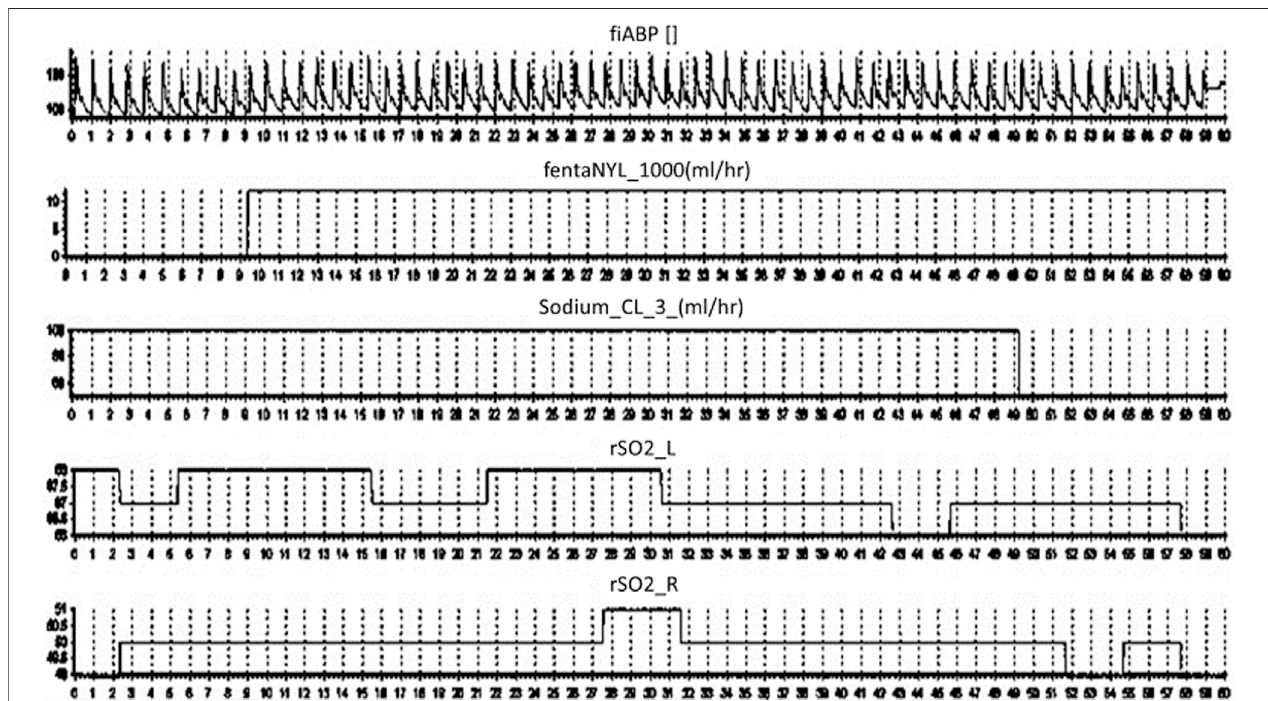
FIGURE5| ICM+FinalOutput.Displays the fi naloutput onICM+overa60 speriod from toptobottom; thearterial blood pressure, fentanyl,sodium chlorideand regional oxygen saturations.